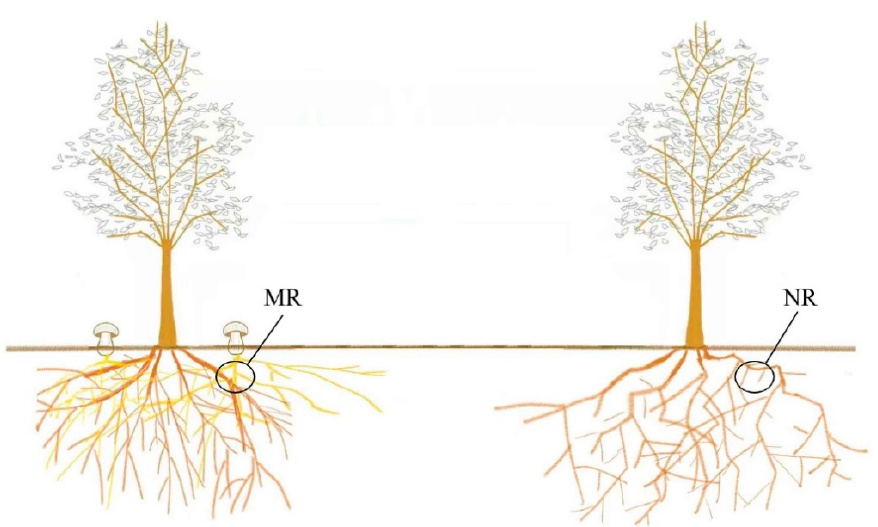
Figure 1. Schematic diagram of sample plot. “MR” refers to the mycorrhizal rhizosphere with a fruiting body. “NR” refers to the non-mycorrhizal rhizosphere without a fruiting body.